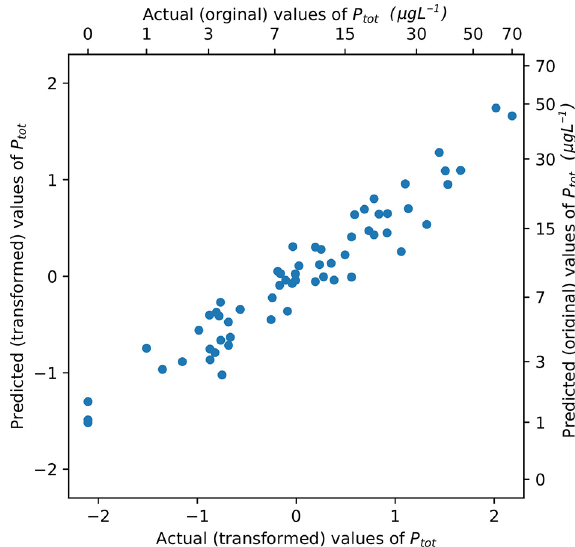
Fig. 5. Relation between actual values of dependent variables and the outcome of the model P